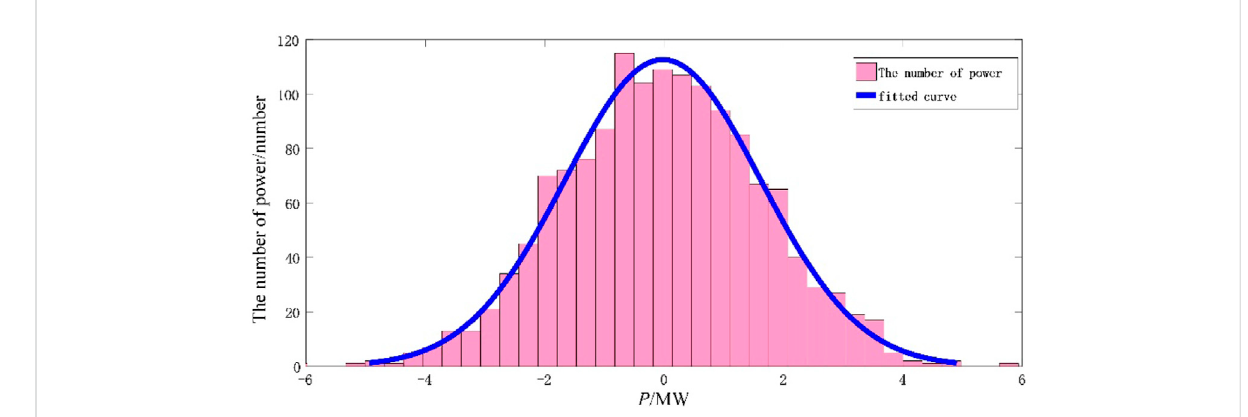
FIGURE 8 Power distribution diagram of the supercapacitor.